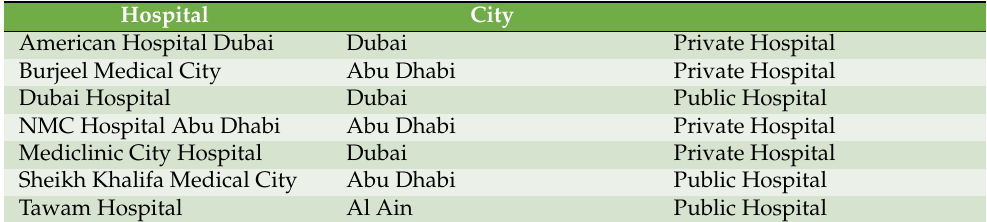
Table 7. Hospitals providing paediatric oncology in the